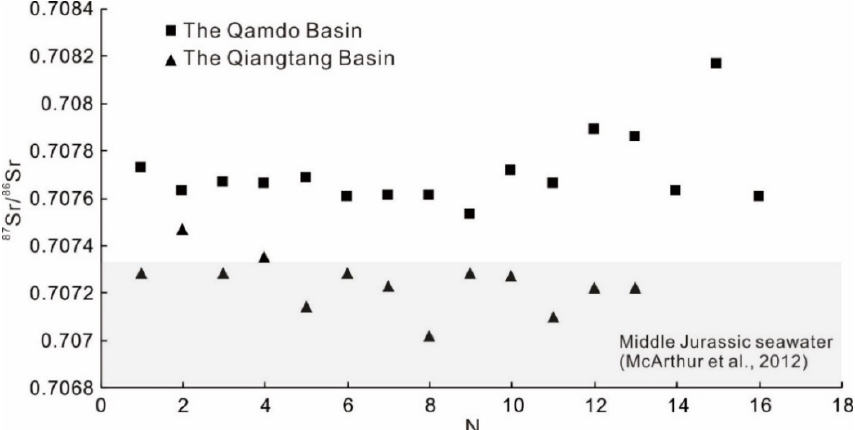
Figure 10. The comparison among the Sr isotope compositions of sulphates in Qamdo Basin, carbonates in Qiangtang Basin, and Middle Jurassic seawater [23].